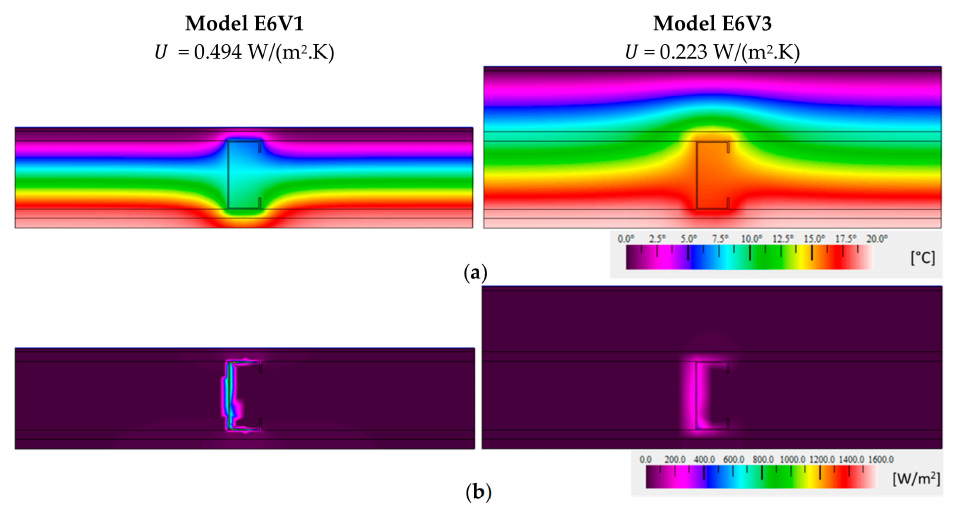
Figure 10. Temperature ( a ) and heat flux ( b ) color distribution for exterior LSF wall models with the highest U -value increase (0 mm EPS ETICS) and decrease (80 mm EPS